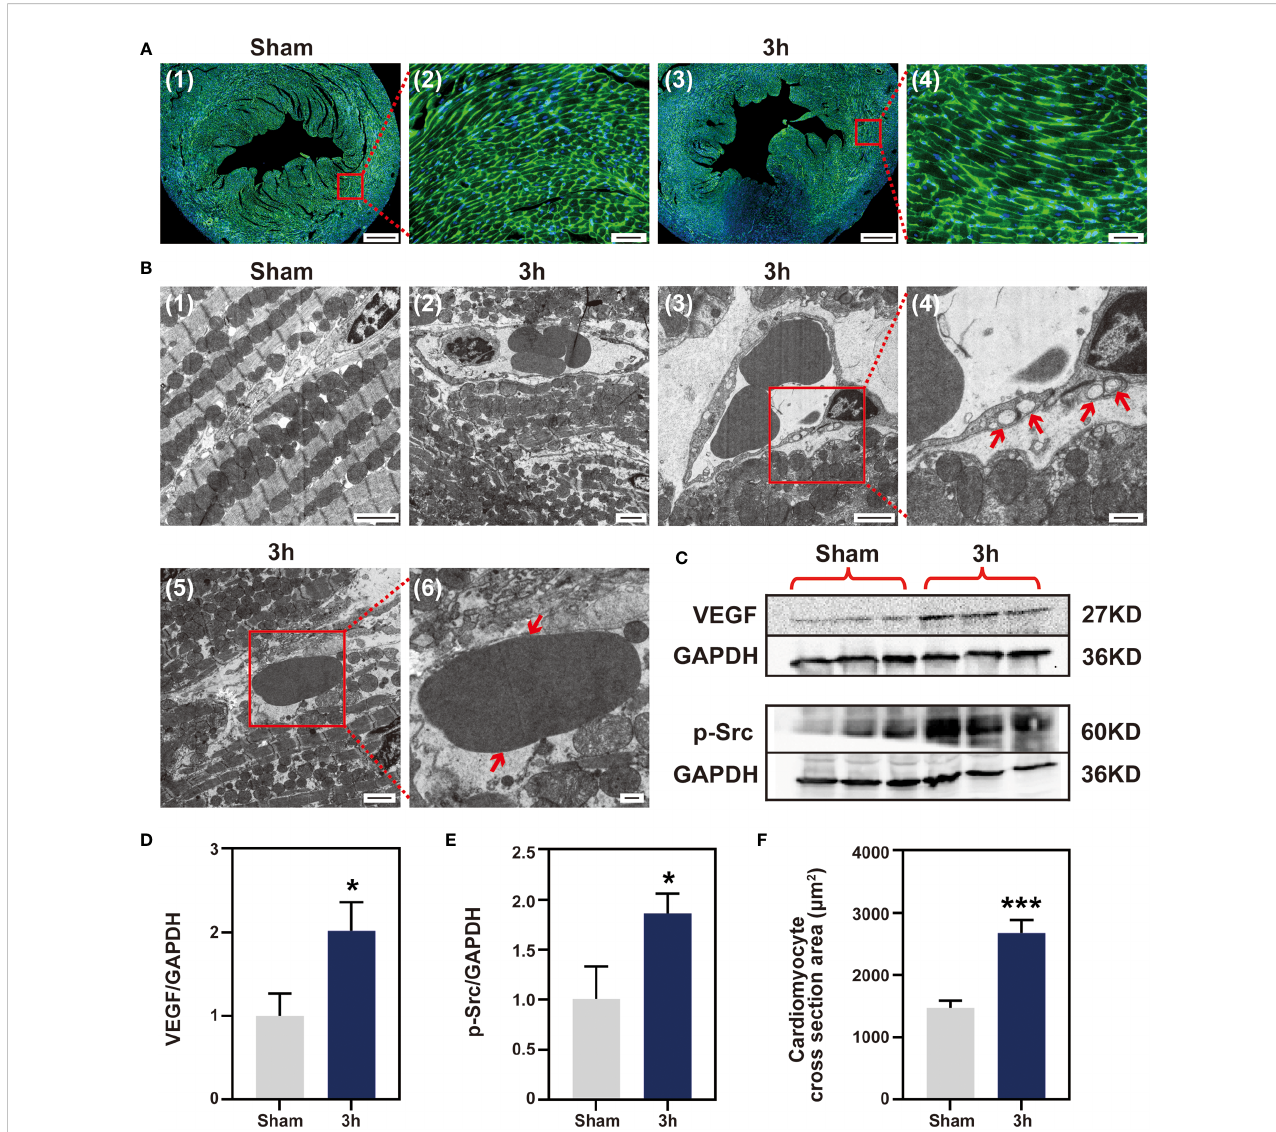
FIGURE 6 Myocardial IR induced edema at 3 h post-IR. (A) , WGA staining cardiomyocyte hypertrophy, (n = 3) (Bar=400 m m, 50 m m). (B) (1-6), ultrastructural changes in mouse myocardium. (1), sham group ventricular myocardium showing normal myo fi lament architecture and mitochondria (Bar=2 m m). (2), anomalous myo fi laments and mitochondria are displayed after IR 3 h (Bar=2 m m). (3-4), Vessel with no apparent gaps, but several large vacuoles apparent (Bar=2 m m, 500nm). (5-6), section transverse to myocardium showing an RBC in the extracellular space (Bar=2 m m, 500nm). (C) , western blotting detect VEGF and p-Src protein expression, (n = 3). Quantitative of VEGF protein (D) , p-Src protein (E) and cardiomyocytes area (F) . RBC, red blood cell; VEGF, vascular endothelial growth factor; p-Src, phosphor-Src, *p < 0.05 VS Sham, ***p <